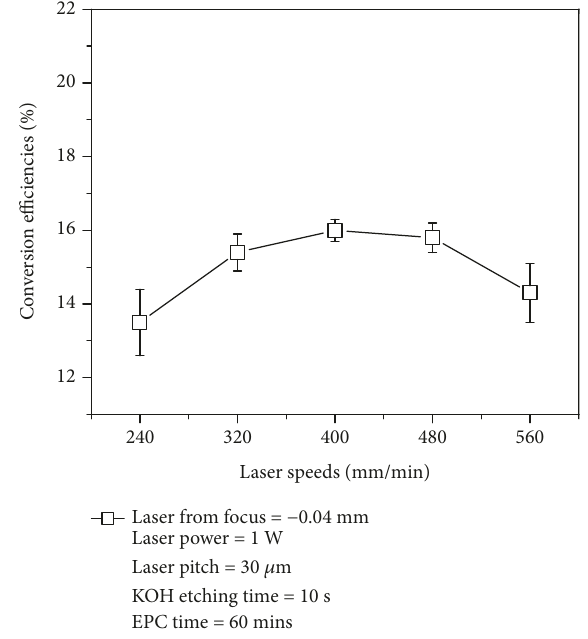
Figure 4: Conversion e ffi ciency vs. laser speed curve of SPMSCs with a B-BSF seed layer and EPC contact layer as the rear